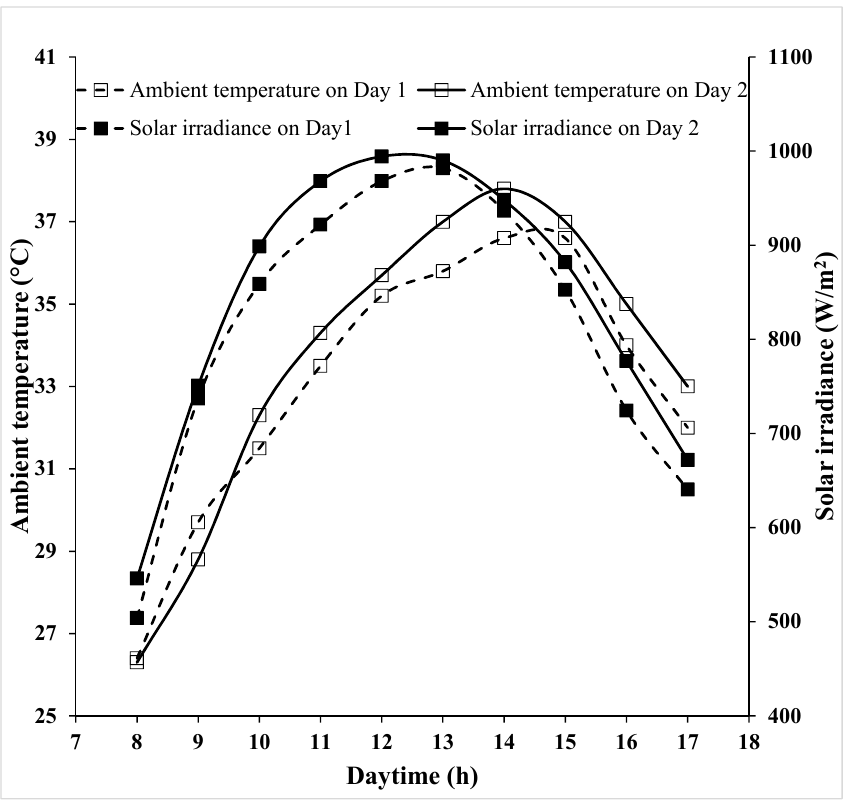
Figure 4. Meteorological conditions for 27 August (day 1) and 28 August (day 2) 2021.